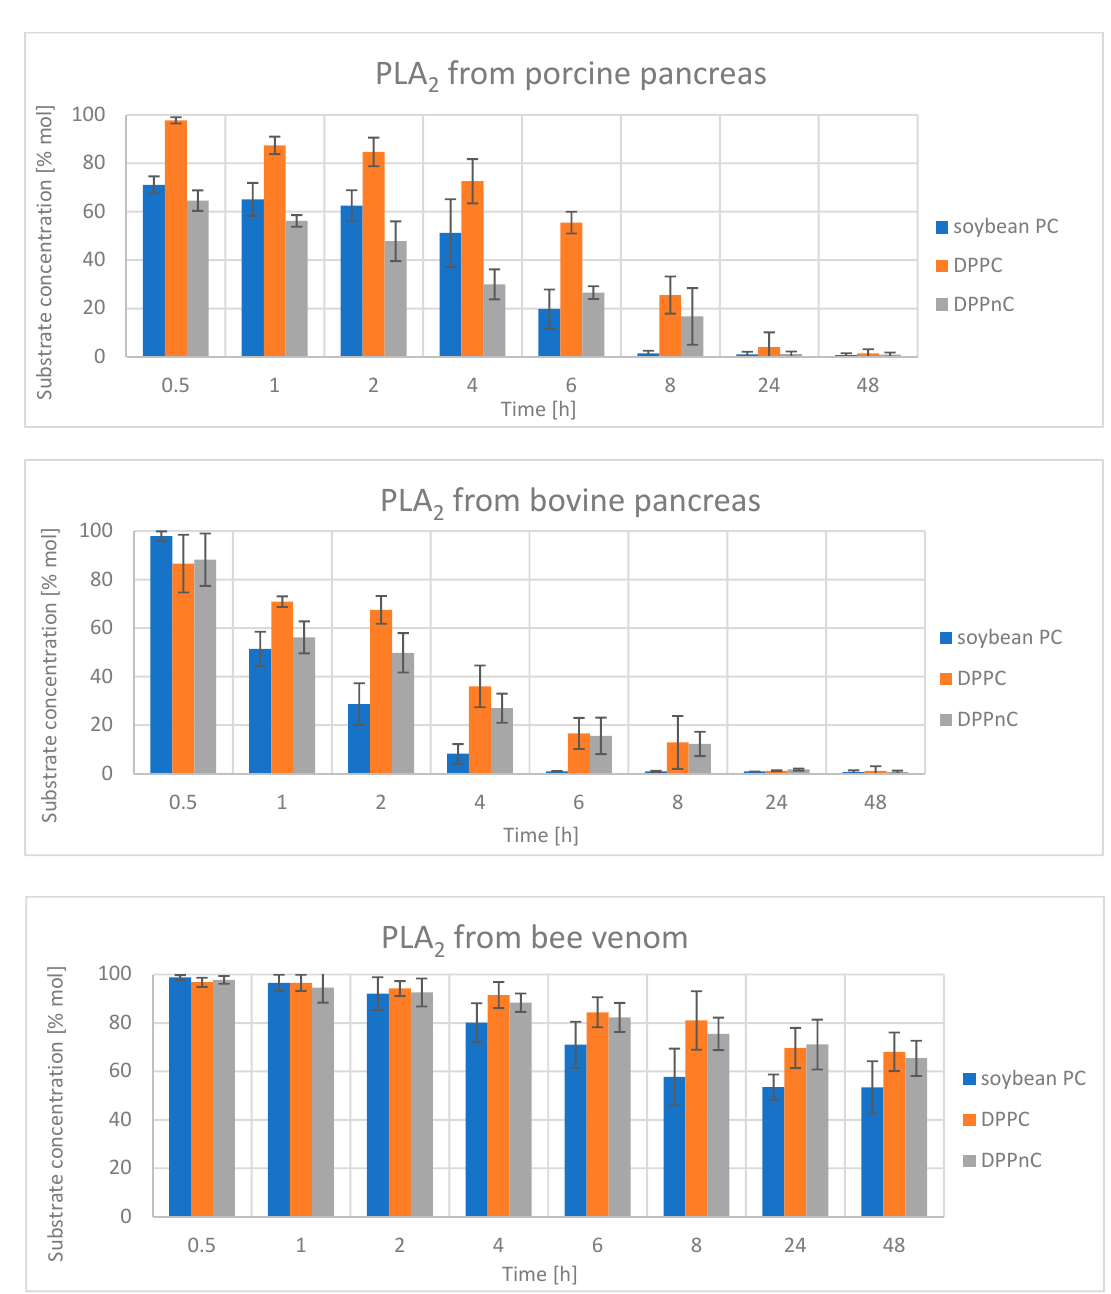
Figure 3. Enzymatic hydrolysis of DPPnC, DPPC and soybean PC by phospholipases A 2 . Results are presented as means ± standard deviation.